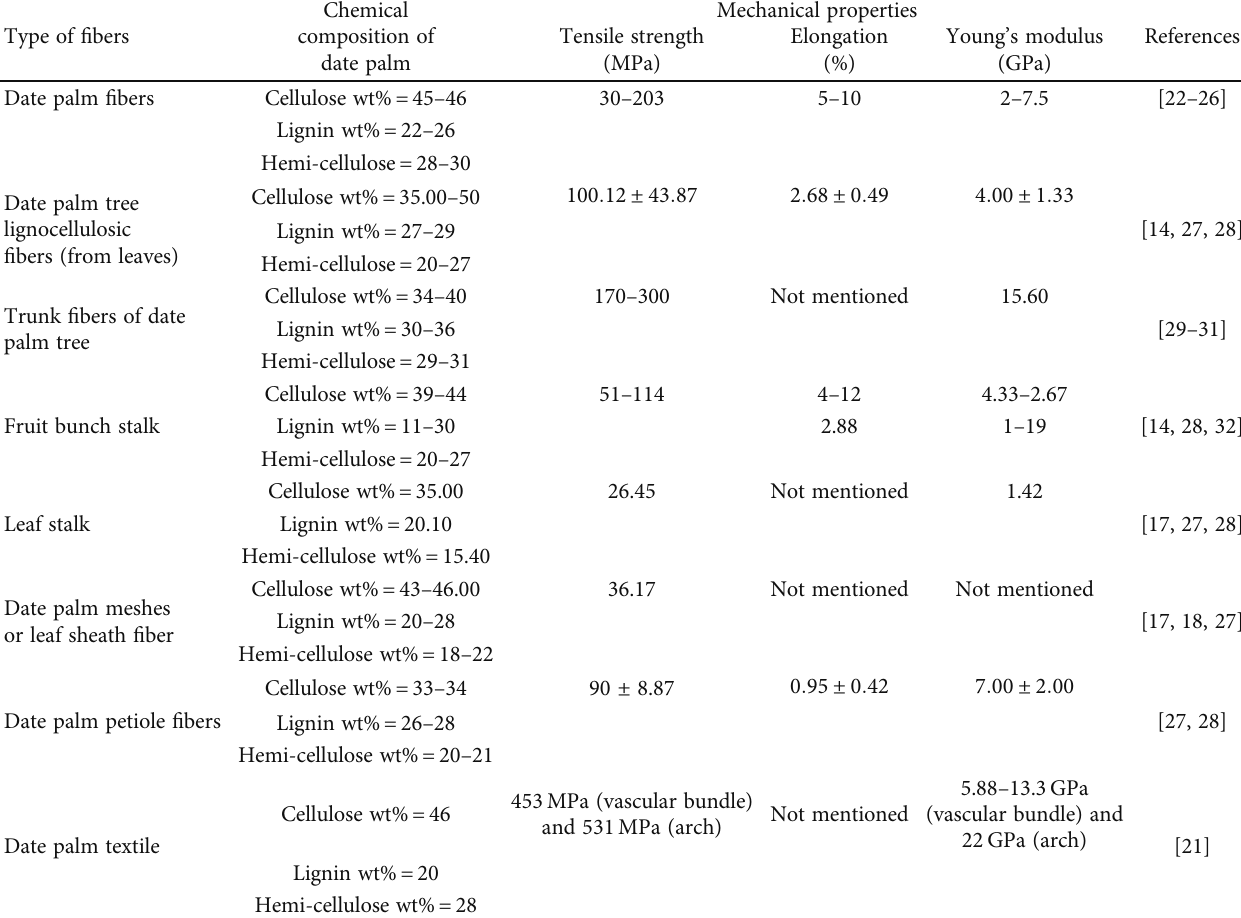
Table 2: Mechanical results of epoxy – DPF composites in the literature featuring di ff erent fi ber types and chemical composition. Type of fi bers